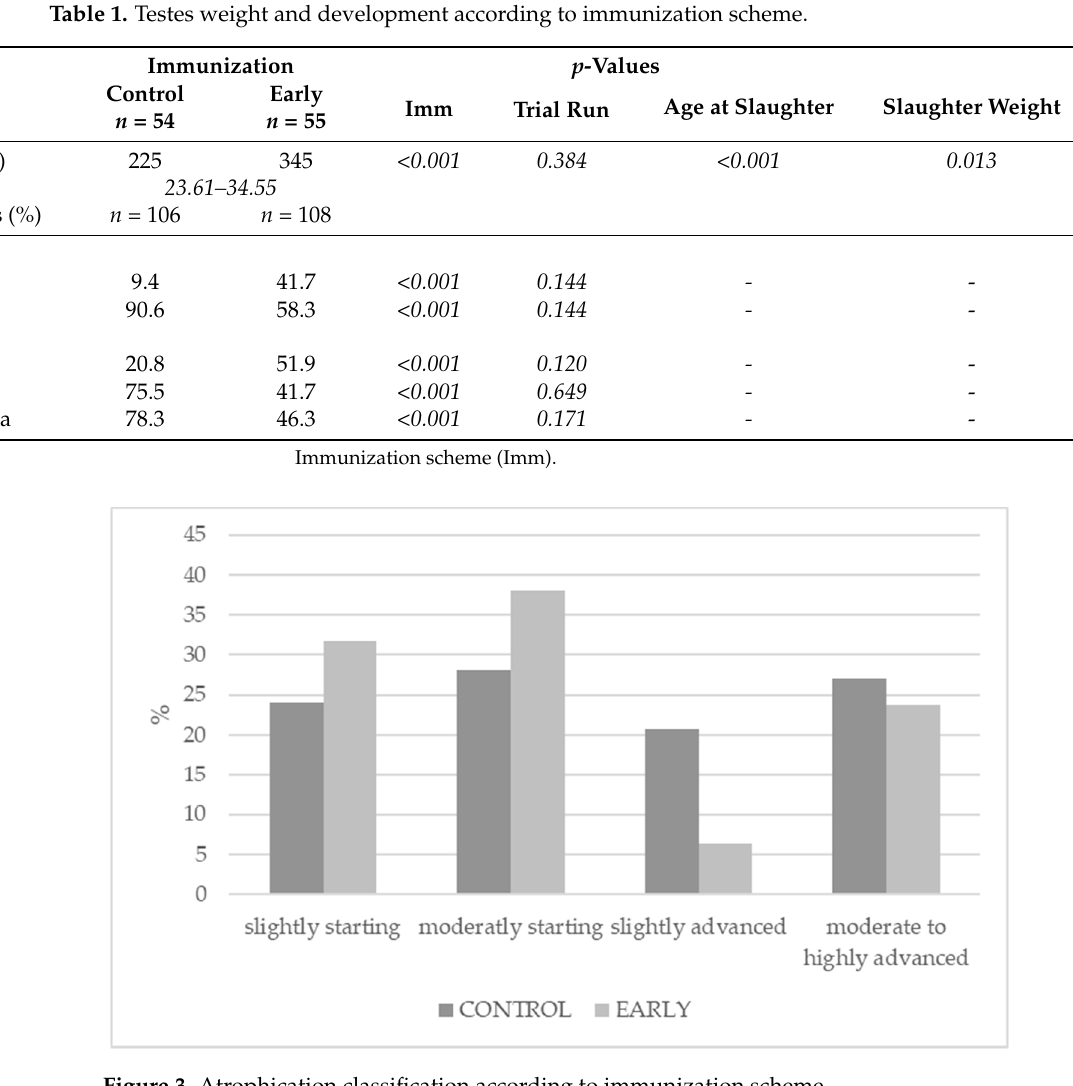
Figure 4. Testosterone levels depending on the number of weeks from the second immunization to slaughter according to the immunization scheme. GnRH binding was significantly higher in the CONTROL pigs by 16.5% and was influenced by the age at slaughter (see Table A4), whereas GnRH binding decreased with increasing age. Although GnRH binding of nearly 46% ( n = 21) of the EARLY pigs was at the same level measured for the CONTROL pigs (>30%), the testosterone levels of the EARLY pigs showed highly variable values compared to the CONTROL group (see Figure